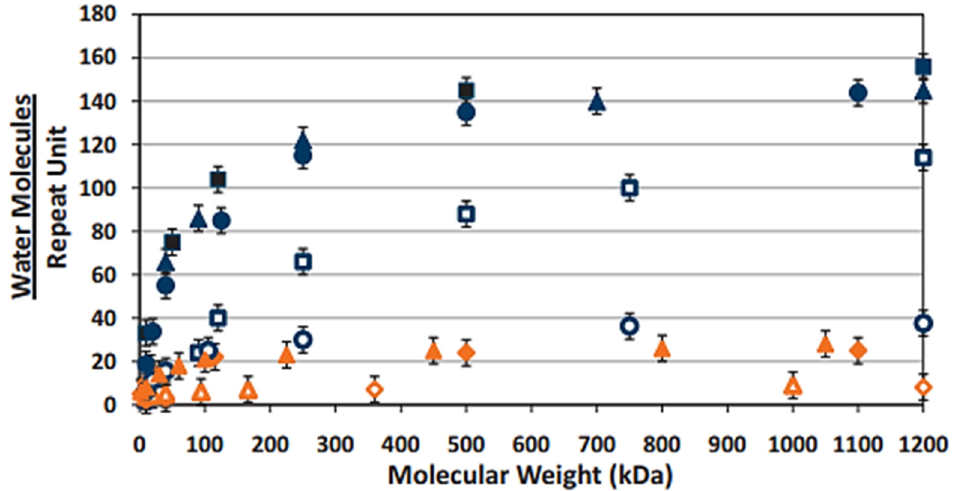
Figure 2 . Water retention per polymer repeat unit of various polyelectrolyte polysaccharides and acrylics. The water retention of HA, ( ) exhibiting superior water retention in comparison to the other polyelectrolyte materials, increases as a function of MW. ( — dextran sodium sulfate, — hy- droxypropyl methylcellulose, — dextran, — carboxymethylcellulose, — poly(acrylic acid), — poly(methacrylic acid), — polyvinyl alcohol, — polyvinyl pyrrilidone). (Reproduced with permission from Ref. [122]. 2014, C. J. White, C. R. Thomas, and M. E. Byrne “Bringing comfort to the masses: A novel evaluation of comfort agent solution properties”; published by Contact Lens and Anterior Eye.